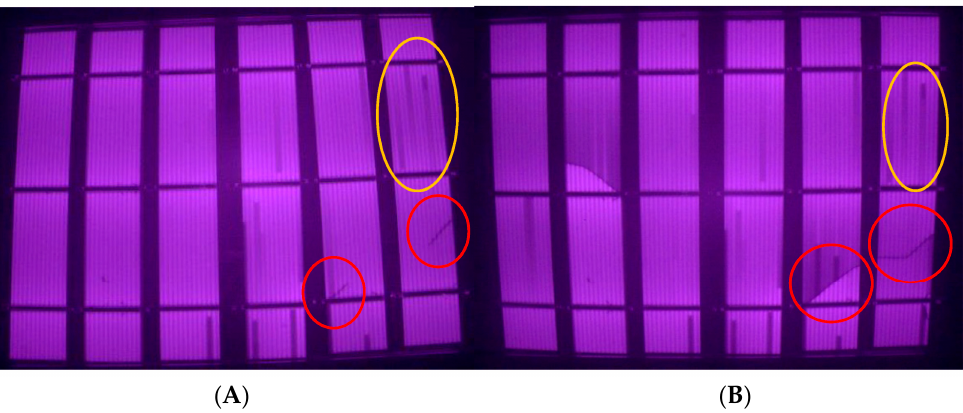
Figure 8. EL test of receiver 5. ( A ) Baseline (ambient temperature); ( B ) After the round at 200 ◦